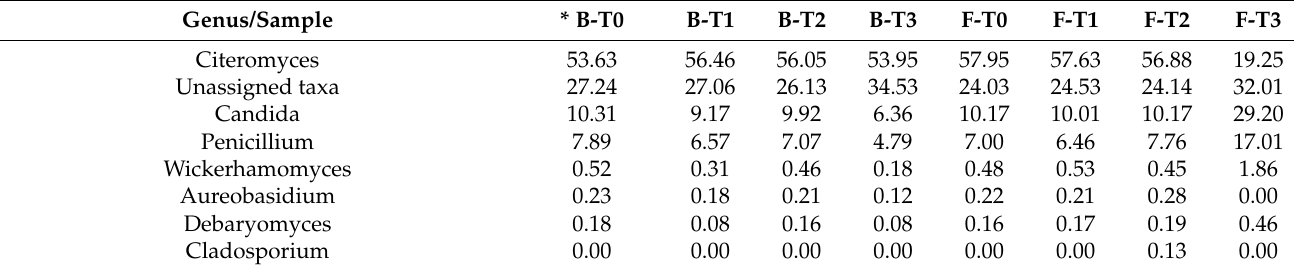
Table 3. Relative abundance of sequences (%) to genus level, obtained by metataxonomic analysis of ITS data samples belonging to traditional packed Aloreña de M á laga . Mean values were obtained from independent duplicates. Only those genera with abundance >0.1% in at least one sample are